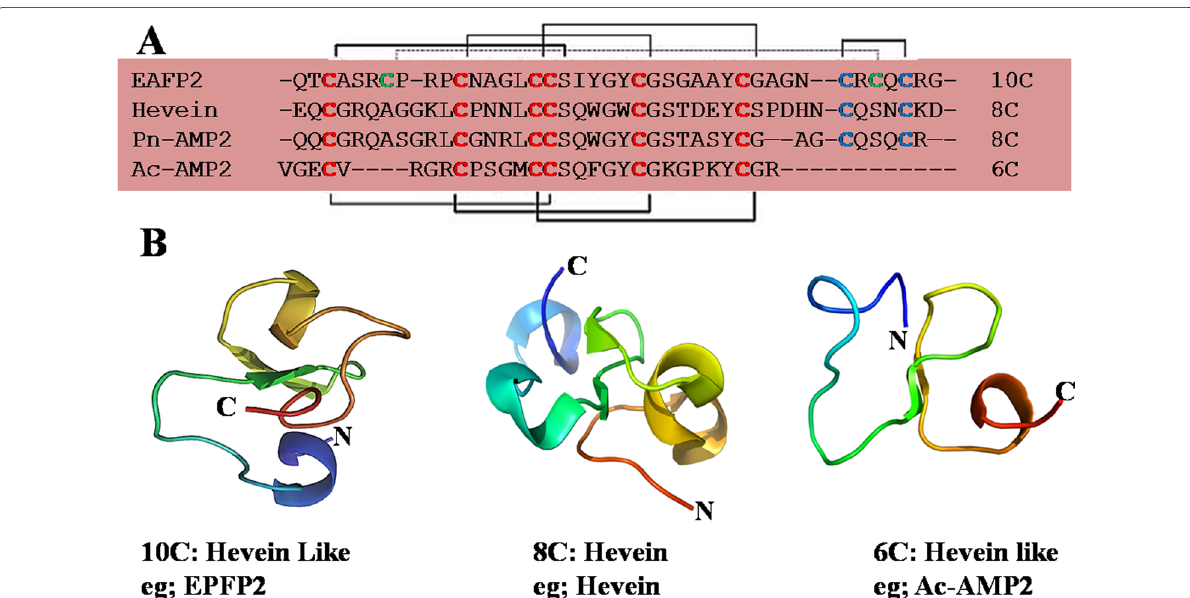
Fig. 2 Overlapping sequence and tertiary structure of the different types of hevein or hevein-like protein/peptides ( a ). An overlapping sequence of different hevein and hevein-like peptides/proteins; bold grey C in the sequence represents conserved cys position throughout different groups, viz. 10C, 8C, and 6C of hevein-like peptide and different family plants, grey C represents additional cys of group 8C, which involve in disulphide bridge of C-terminus, light grey C represents furthermore additional cys of 10C which connect N-to C terminus through disulphide bond and –dash line placed to denotes variability in length in the process of alignment of sequence ( b ). The tertiary structure of each representative group of hevein-like